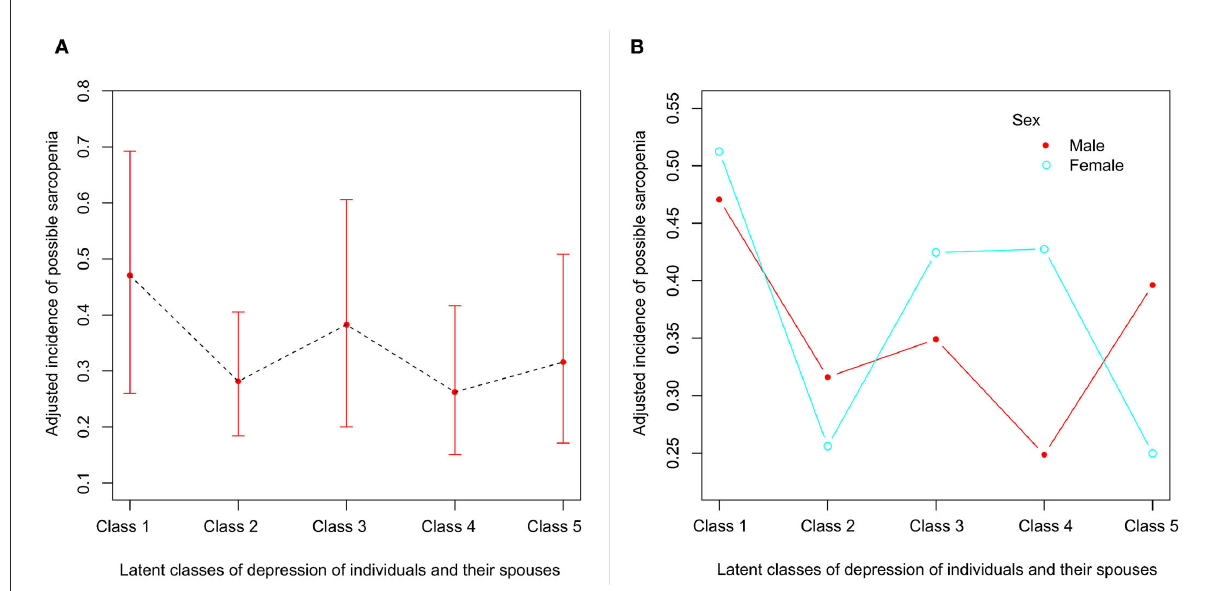
FIGURE3 (A) The adjusted incidence of the different latent classes of depression in individuals and their spouses. Class 1: a persistently high risk of depression in individuals and their spouses; class 2: a persistently low risk of depression in individuals and their spouses; class 3: a high risk of depression in individuals and a low risk of depression in individuals’ spouses; class 4: a low risk of depression in individuals and a high risk of depression in individuals’ spouses; and class 5: the decreased risk of depression in individuals and their spouses. (B) The adjusted incidence of the different latent classes of depression in individuals and their spouses when stratified by sex.